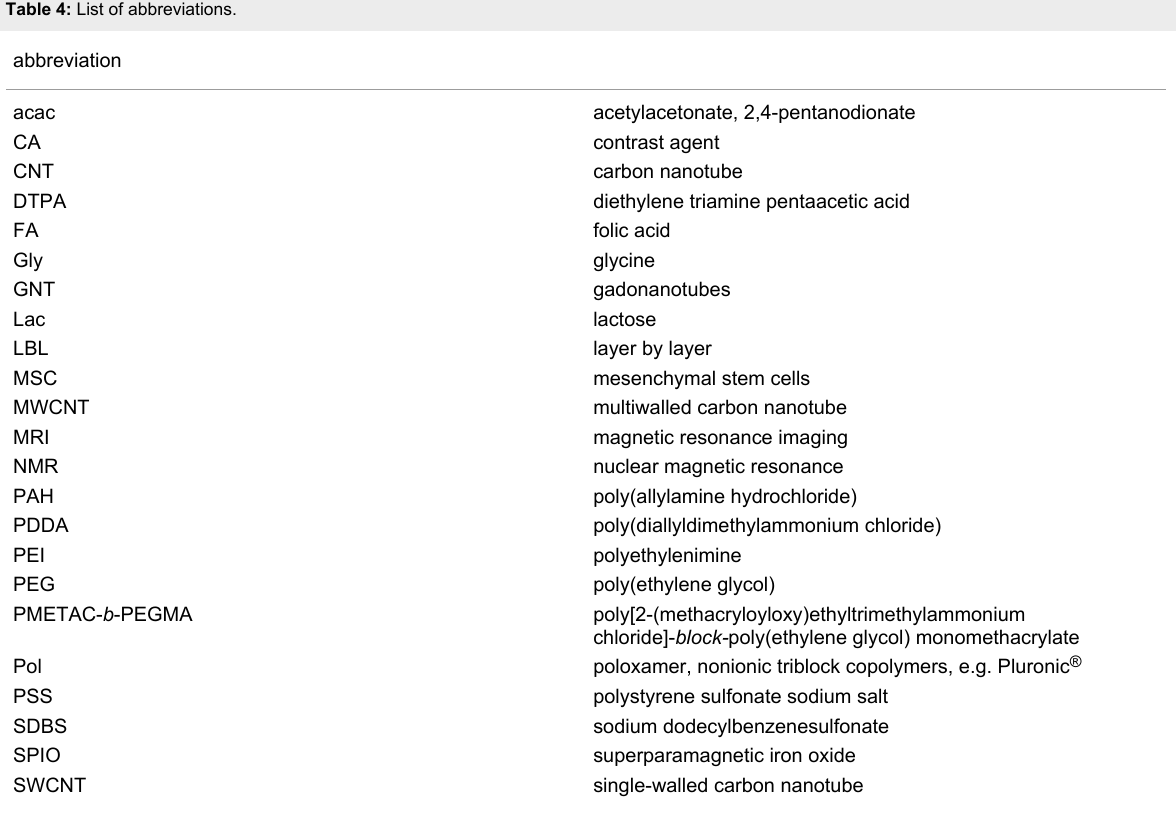
Table 4 gives a list of abbreviations used in the